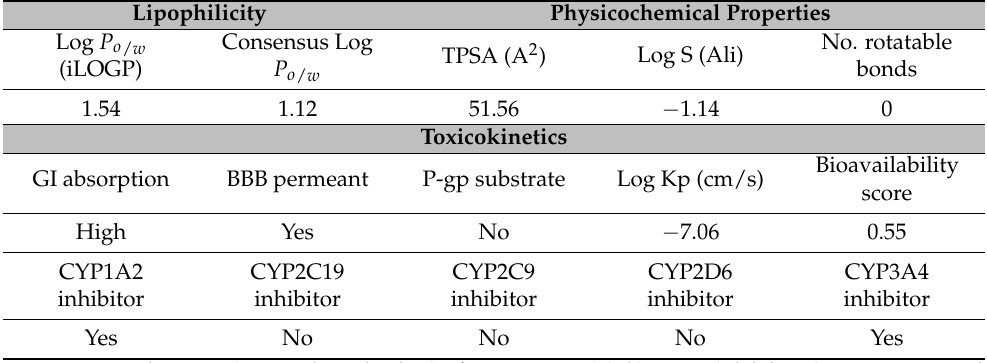
Table 2. Toxicokinetic properties of phenanthrene based on its physico-chemical and ADME/Tox (for absorption, distribution, metabolism, elimination, and toxicity) attributes.